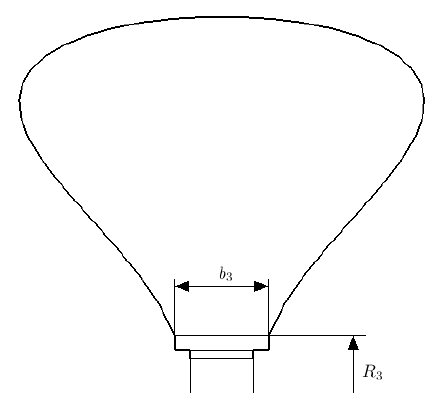
Figure 7. Vaneless diffuser width, b 3 and outlet radius, R 3